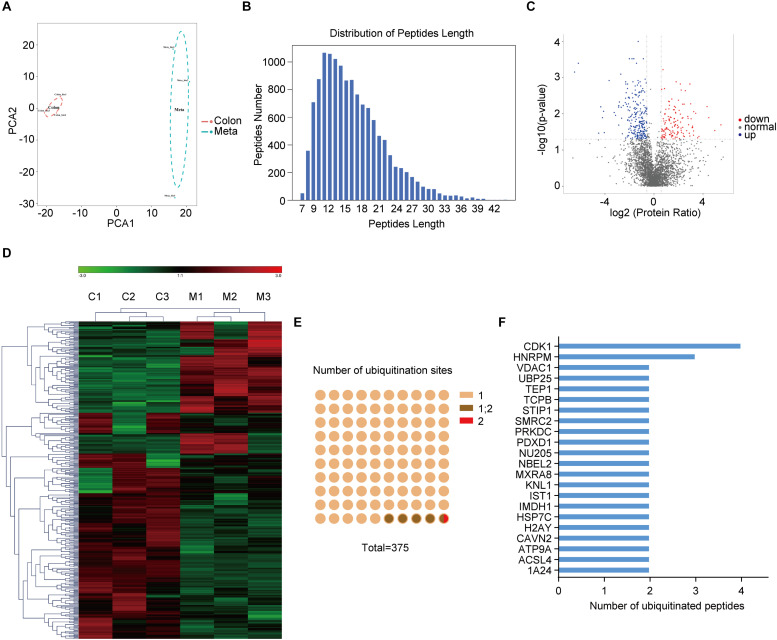
The ubiquitination profile in human primary and metastatic colon adenocarcinoma tissues. (A) Principal component analysis (PCA) shows the statistical discrimination between Mass Spectrometry (MS) profile of the primary (Colon) and metastatic (Meta) colon adenocarcinoma tissues. The highlighted area for each component corresponds to a confidence interval of 95%. (B) Distribution of peptide length of all ubiquitinated peptides. (C) Volcano plot showing ubiquitylated proteins that are significantly (| Fold change| > 1.5, p < 0.05) different between the Meta and Colon group. (D) Heat map illustrating identified proteins with different ubiquitin modification in Meta (M) and Colon (C) group. (E) Number of ubiquitination sites on the identified ubiquitinated peptides. (F) Ubiquitinated peptides shared the same parent proteins.